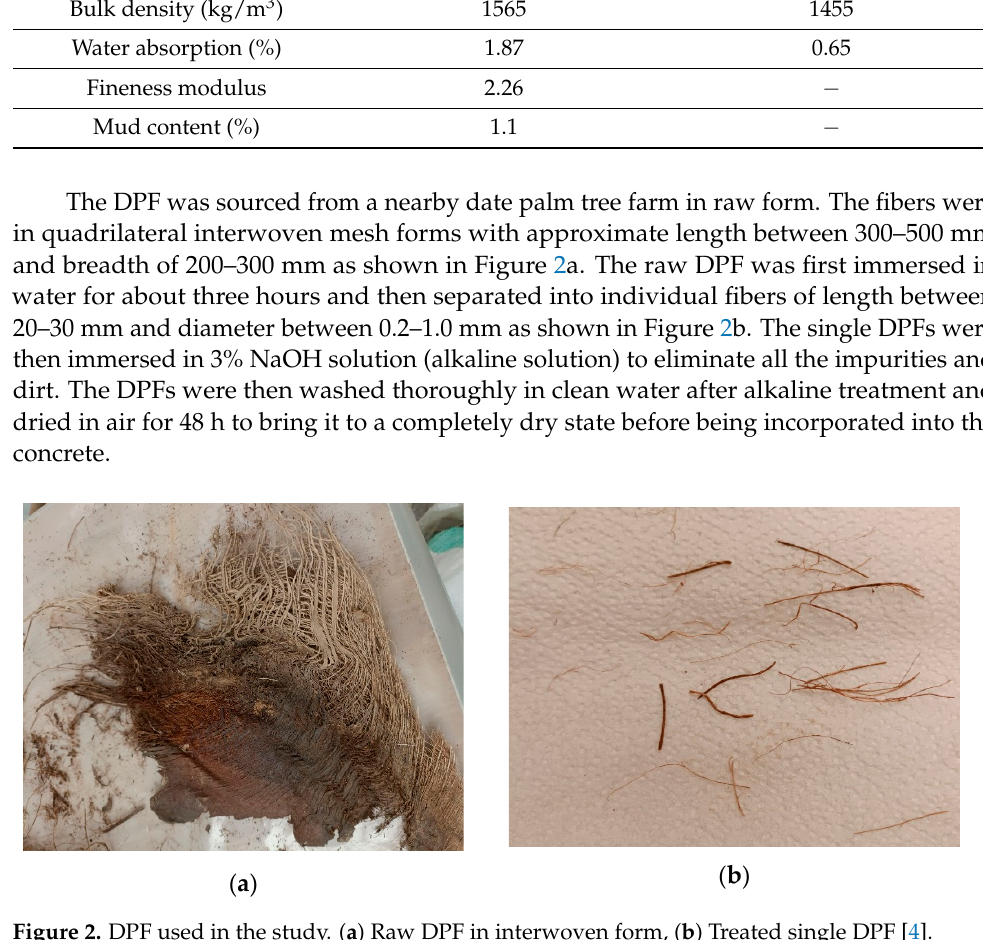
Figure 2 . DPF used in the study. ( a ) Raw DPF in interwoven form, ( b ) Treated single DPF [4].